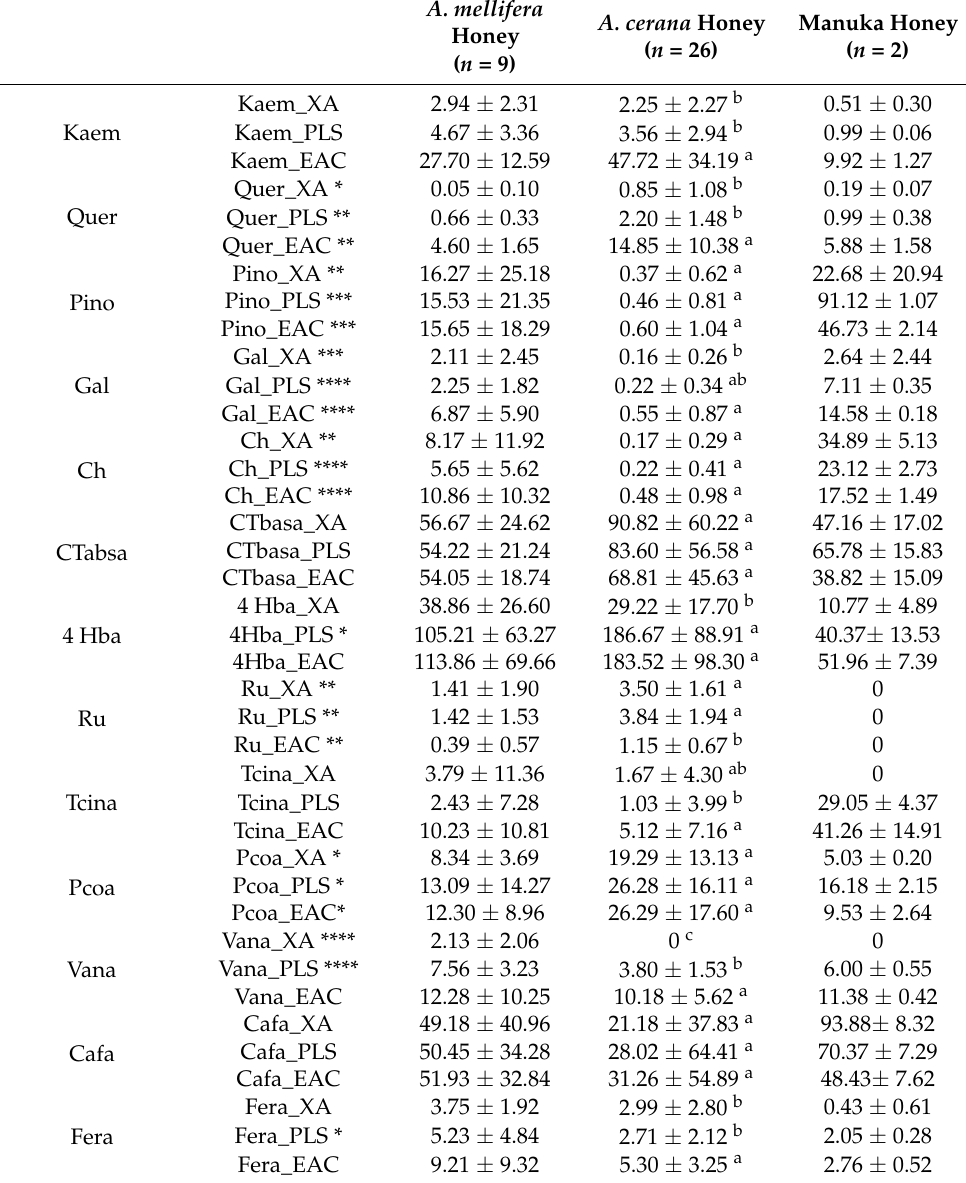
Table 2. The average content of phenolic compounds ( µ g/100 g honey) in A. cerana and A. mellif- era